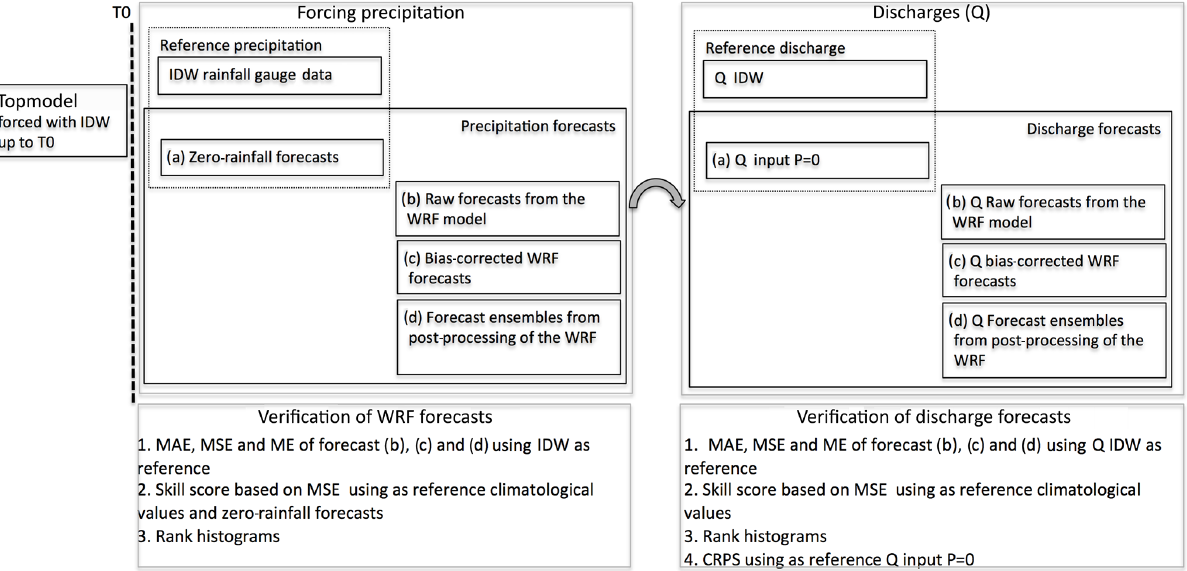
Figure 2. Overview of the